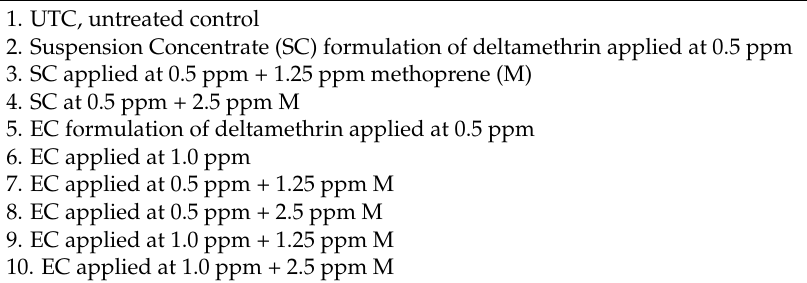
Table 1. List of insecticide treatments and abbreviations used in the following